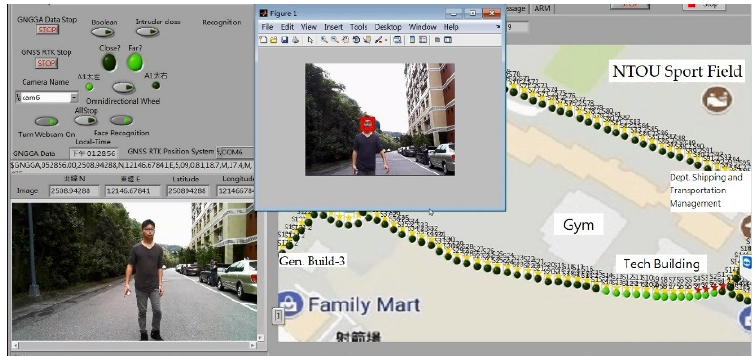
Figure 24. The robot identified the person appearing in front of it.